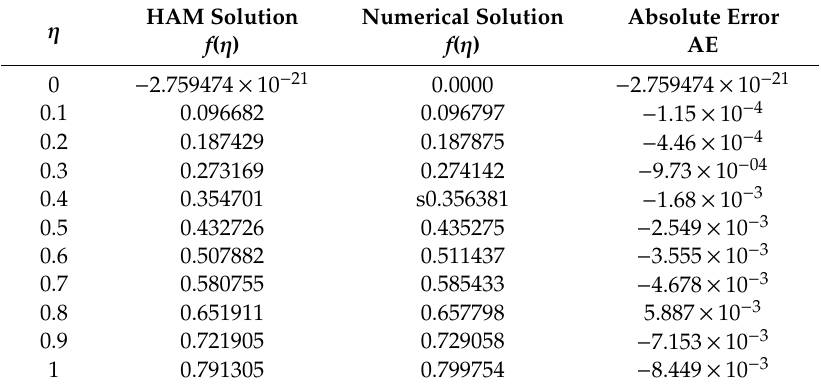
Table 2. The relationship between Homotopy Analysis Method (HAM) and Numerical techniques for f ( η ) in case of n = 0, when β = ε = 1, St = M = 0.1, ξ = 0.8.